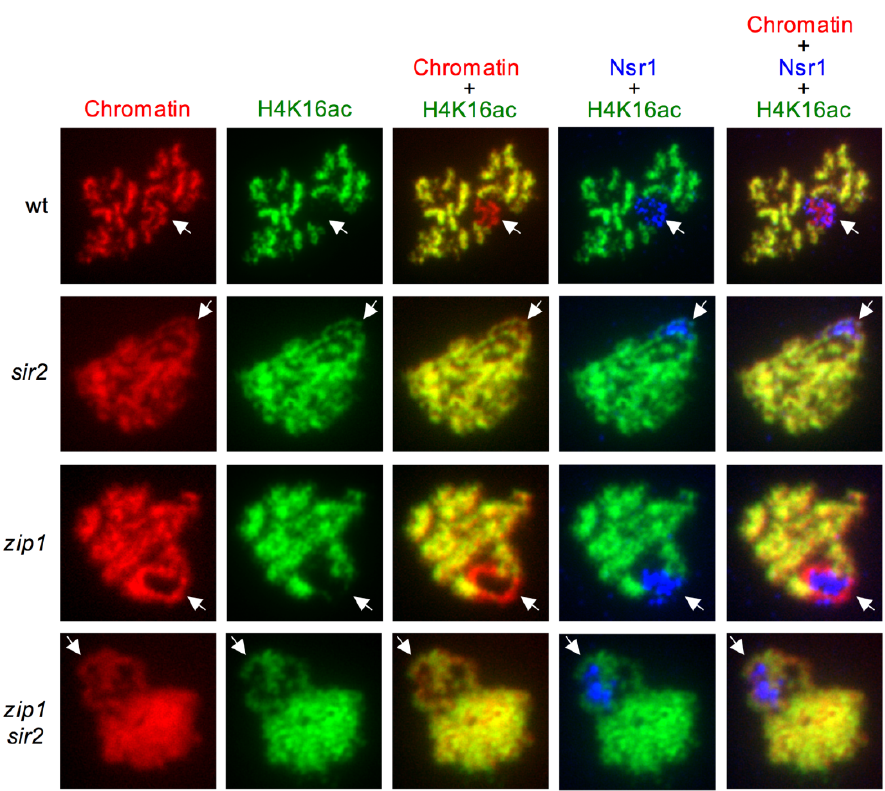
FIGURE 9: Sir2 excludes H4K16ac from the rDNA region. Immuno- fluorescence of meiotic chromo- some spreads from wild type (BR2495), sir2 (DP262), zip1 (DP1123) and zip1 sir2 (DP1124), stained with DAPI (red) as well as with anti-H4K16ac (green) and anti-Nsr1 (blue) antibodies. The arrows point to the rDNA region identified by Nsr1 staining. Rep- resentative nuclei are